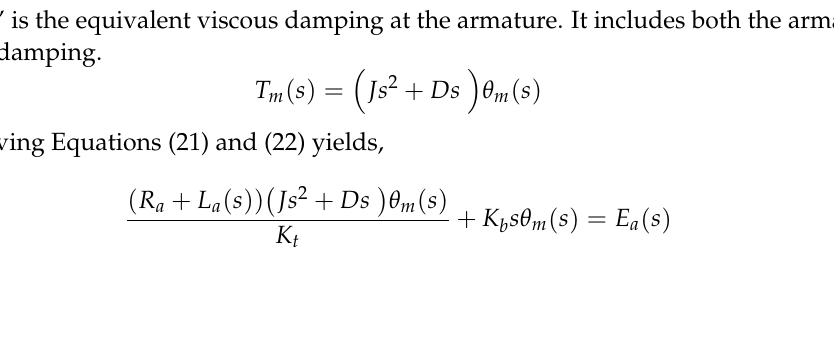
Figure 6. Representation of mechanical load in